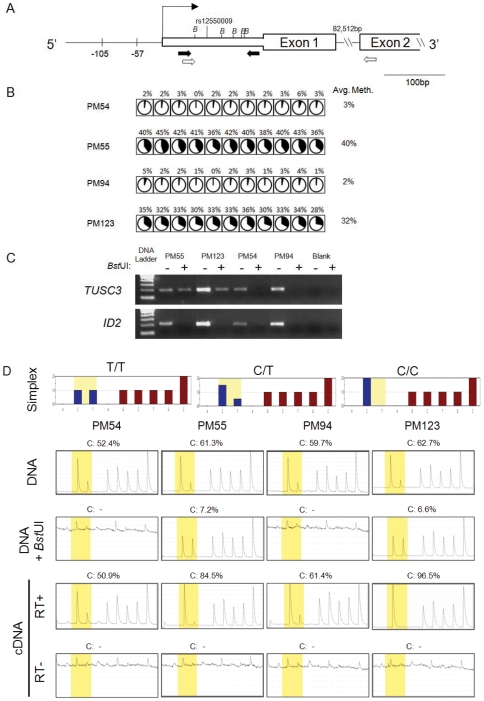
Promoter CpG methylation correlates with lack of TUSC3 gene expression.(A) Schematic of TUSC3 locus showing the regions investigated by bisulfite pyrosequencing on the promoter (−105 to −57 relative to the transcriptional start site according to NM_006765) and genotyping assays of the 5′ untranslated region. PCR primers for DNA genotyping are indicated by black arrows while RT-PCR primers for mRNA genotyping are indicated by arrows highlighted in white. Enzyme recognition sites for BstUI are indicated by “B”. (B) Methylation status of TUSC3 promoter region studied by bisulfite pyrosequencing. A similar methylation level of every CpG within each sample is observed and the gene follows “on-or-off” methylation pattern. Each circle represents a CpG site in a sample. Area shaded in black is proportional to the methylation level of the CpG site indicated by pyrosequencing. (C) Validation of complete methylation-sensitive restriction enzyme digestion on unmethylated molecules. Genomic DNA was predigested with BstUI followed by PCR amplification with TUSC3 and ID2 specific primers (Table S2). BstUI digestion sites within the ID2 region were unmethylated (Figure S6) and, therefore, no PCR product was generated after enzyme digestion. (D) Allele-specific methylation of TUSC3 on the fragment containing SNP rs12550009 demonstrated by enzyme digestion pyrosequencing. The “Simplex” diagrams (top) show the reference pyrograms by genotype. A heterozygous CT in the methylated samples (PM55 and PM123) displays a homozygous T pattern after BstUI digestion indicating predominant methylation of the T allele. Allele-specific mRNA expression is concordant with allele-specific methylation on the same SNP rs1250009. Predominant expression of C alleles was observed in the cDNAs generated by RNA specific primers (bottom). RT+ and RT− represent assays with Reverse Transcriptase and without Reverse Transcriptase, respectively.